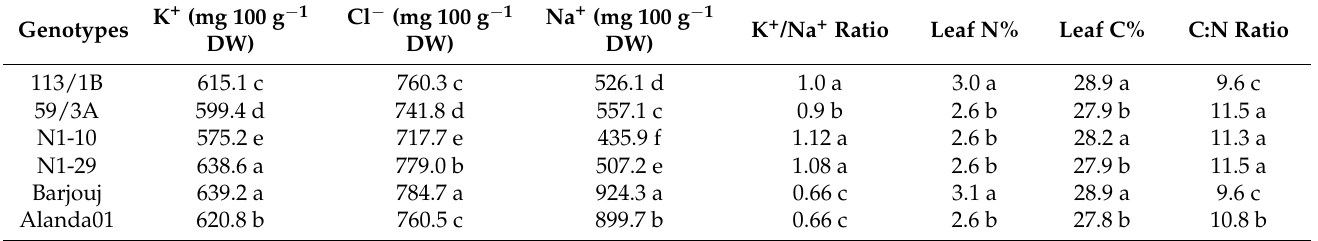
Table 6. Barley genotype difference in biomass and agro-physiological traits across all salinity